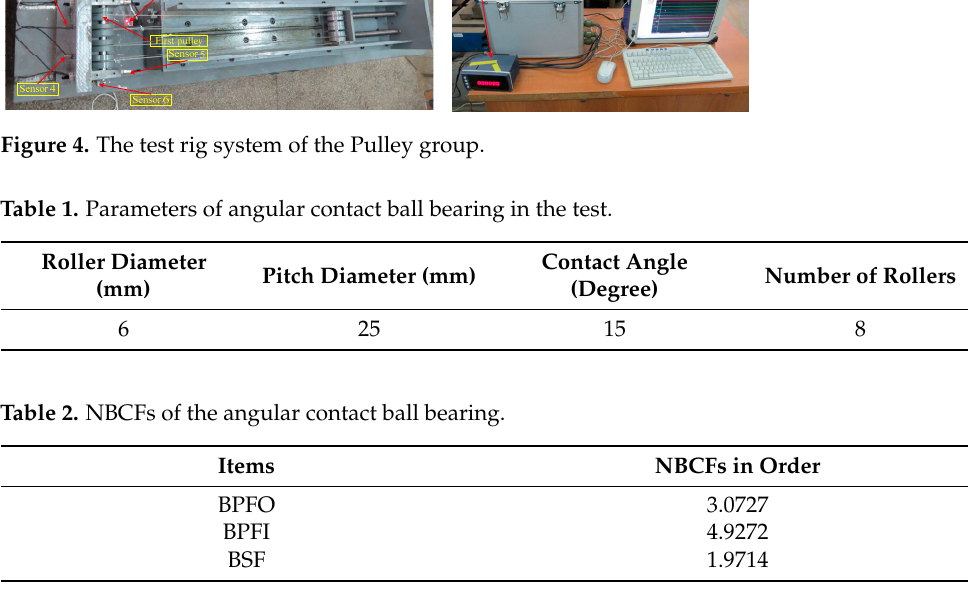
Figure 5. Fault bearings used in the experiment.